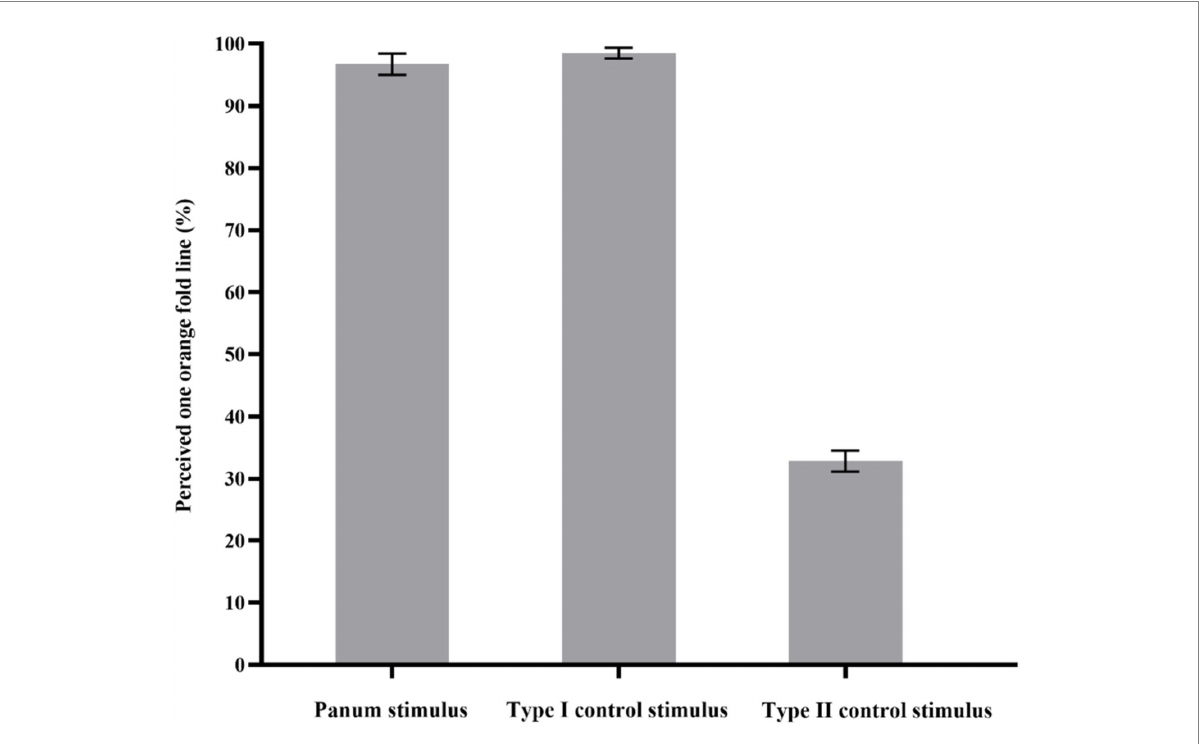
FIGURE 6 Results of Experiment 1. The y-axis indicates the probability that the participants perceived one orange fold line. The x-axis represents the three types of stimuli. The error bars in the figure refer to standard